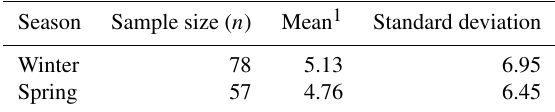
Table 5. Hyperparameters for the best neural network model.